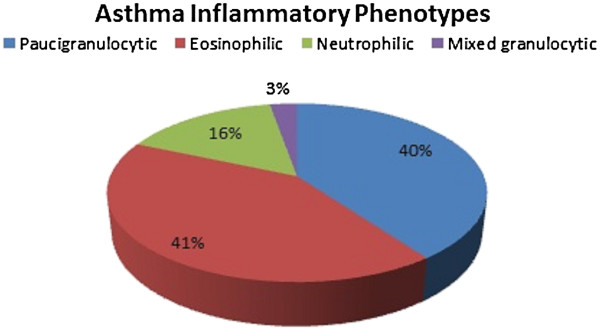
Proportion of various inflammatory phenotypes according to cellularity of induced sputum in a large cohort of asthmatics.